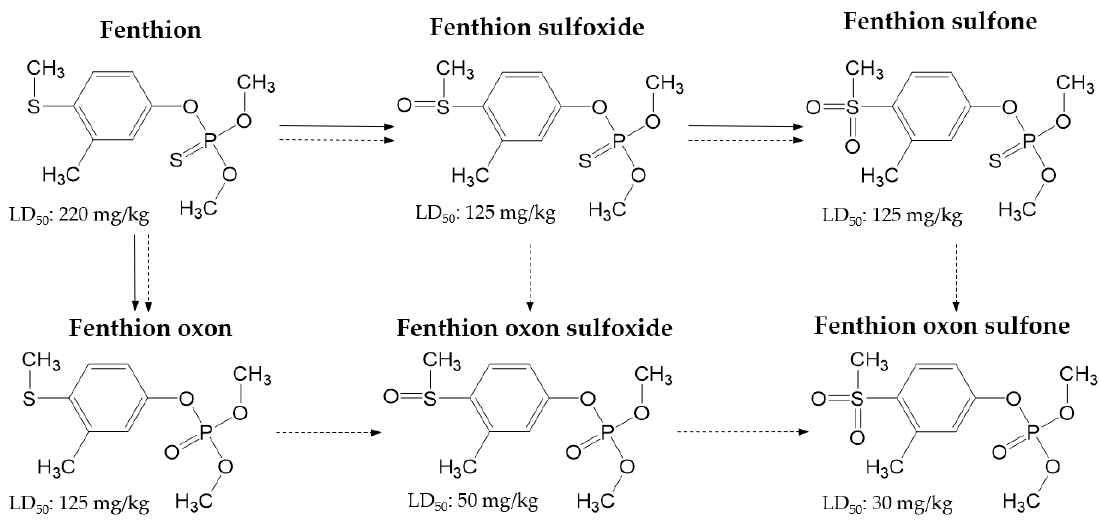
Figure 1. Chemical structures of fenthion and its metabolites covered in this study and their acute oral toxicities (LD 50 for male rats) and the predicted metabolic pathway in mammals (dotted line) [14] and environmental compartments (solid line) [13].